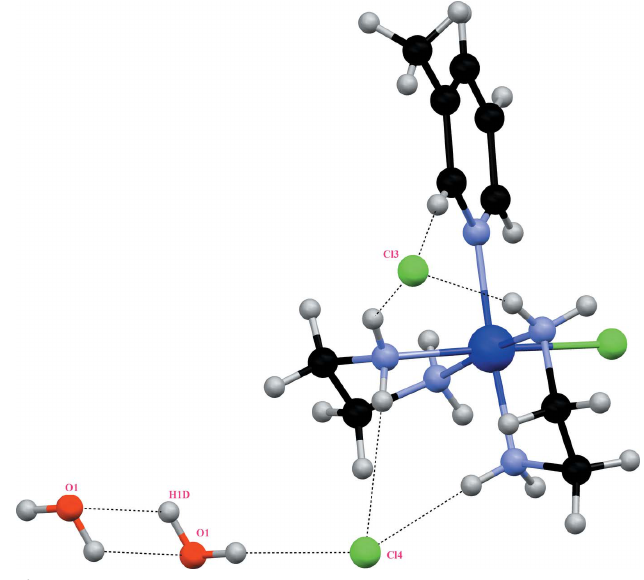
Figure 2 Aview along the a axis of the title compound, emphasizing the molecular packing. N—H (cid:2)(cid:2)(cid:2) Cl, O—H (cid:2)(cid:2)(cid:2) O, O—H (cid:2)(cid:2)(cid:2) Cl and C—H (cid:2)(cid:2)(cid:2) Cl hydrogen bonds are shown as dashed lines (see Table 1 for numerical details).